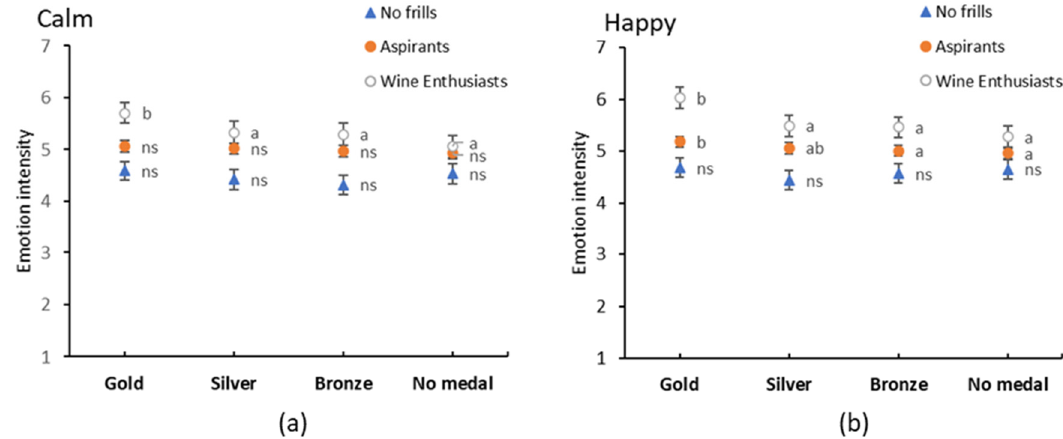
Figure 5. Interaction between fine wine segments (FWS) and quality for ( a ) calm and ( b ) happy emotions. Error bars indicate standard errors. Di ff erent lowercase letters indicate significant di ff erences between wine quality within a FWS based on Fishers LSD post-hoc comparisons, ns—no significant di ff